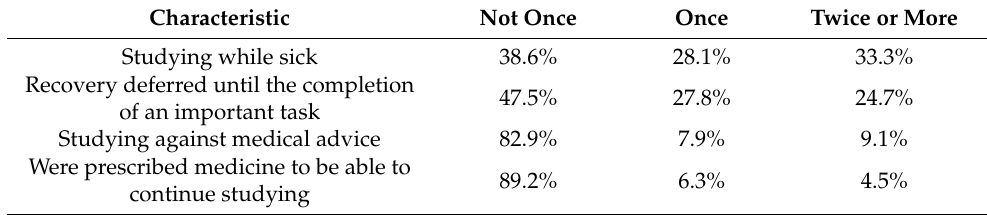
Table 2. Prevalence of presenteeism.